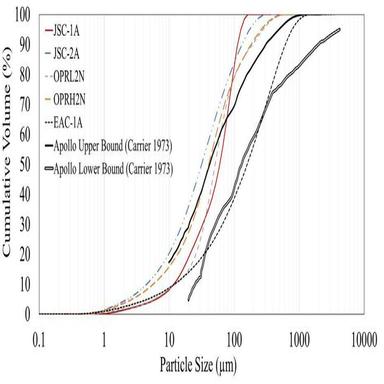
PSD of the five lunar regolith simulants and the combined range of particle sizes for the Apollo 11, 12, 14, and 15 samples.